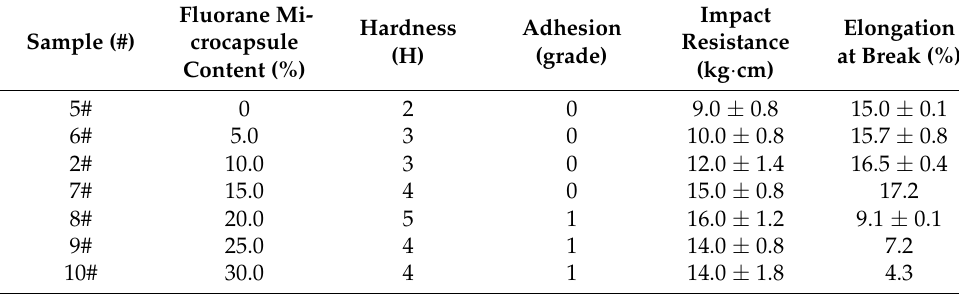
Figure 9. The fluorane microcapsule content on film gloss. Table 7. The fluorane microcapsule content on mechanical